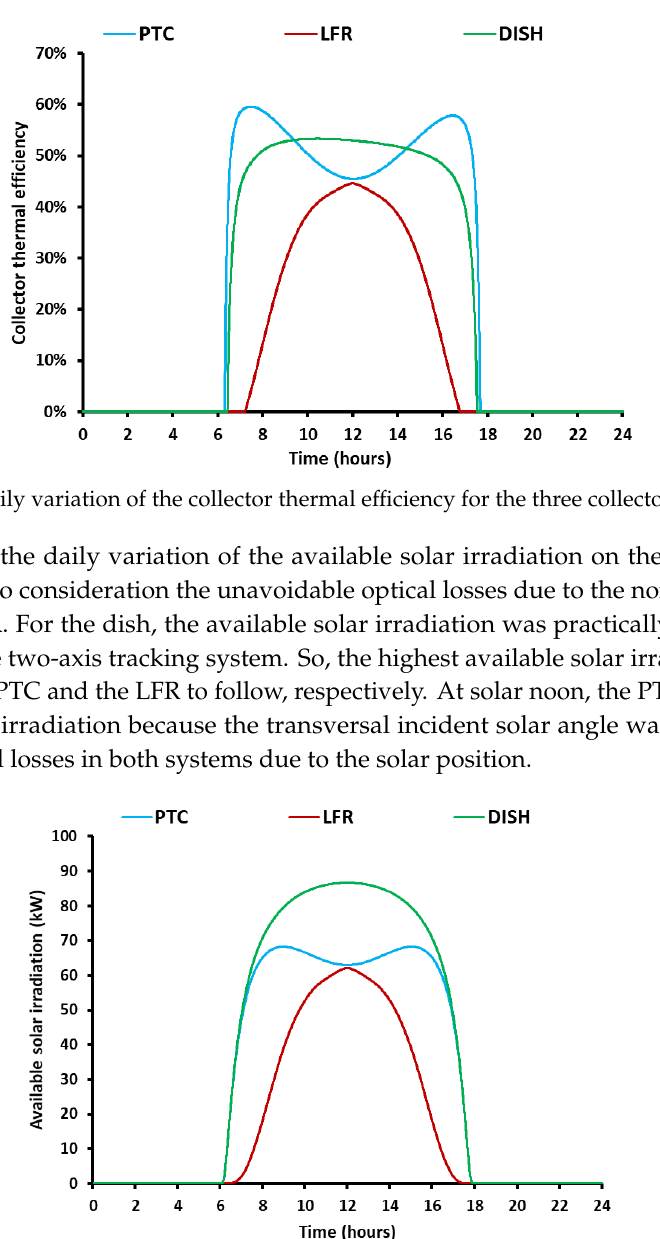
Figure 6. Daily variation of the useful heat production for the three collectors in June. Figure 7. Daily variation of the storage tank mean temperature for the three collectors in June.